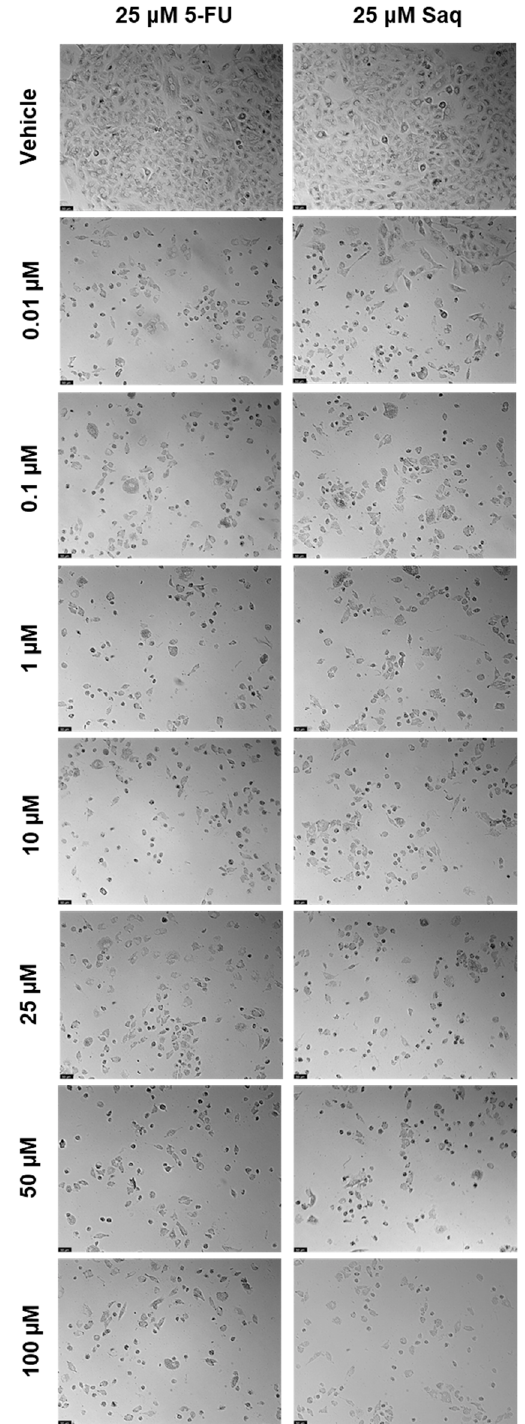
Figure 20. Morphological evaluation of A549 after exposure to combinations of 25 μ M of 5-FU with increasing concentrations of saquinavir (0.01–100 μ M) or 25 μ M of saquinavir with increasing concentrations of 5-FU (0.01–100 μ M) for 48 h. The second drug was only added 24 h after the first drug. Control cells were treated with the vehicle (0.01% DMSO). These images are representative of three independent experiments. The scale bar is 200 μ M.